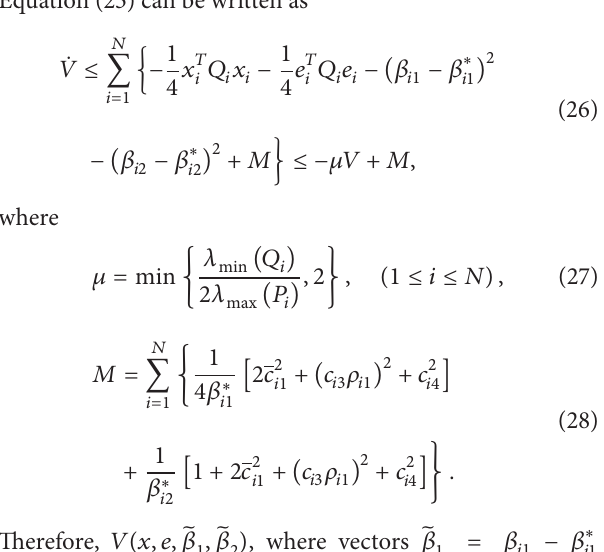
Equation (25) can be written